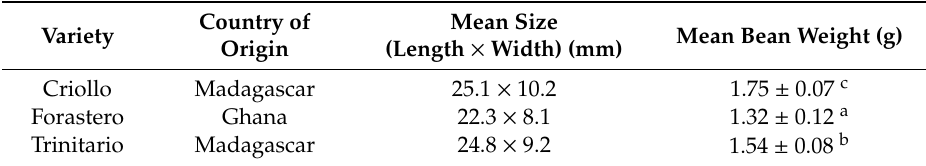
Table 1. Selected physical characteristics of di ff erent cocoa varieties used in the